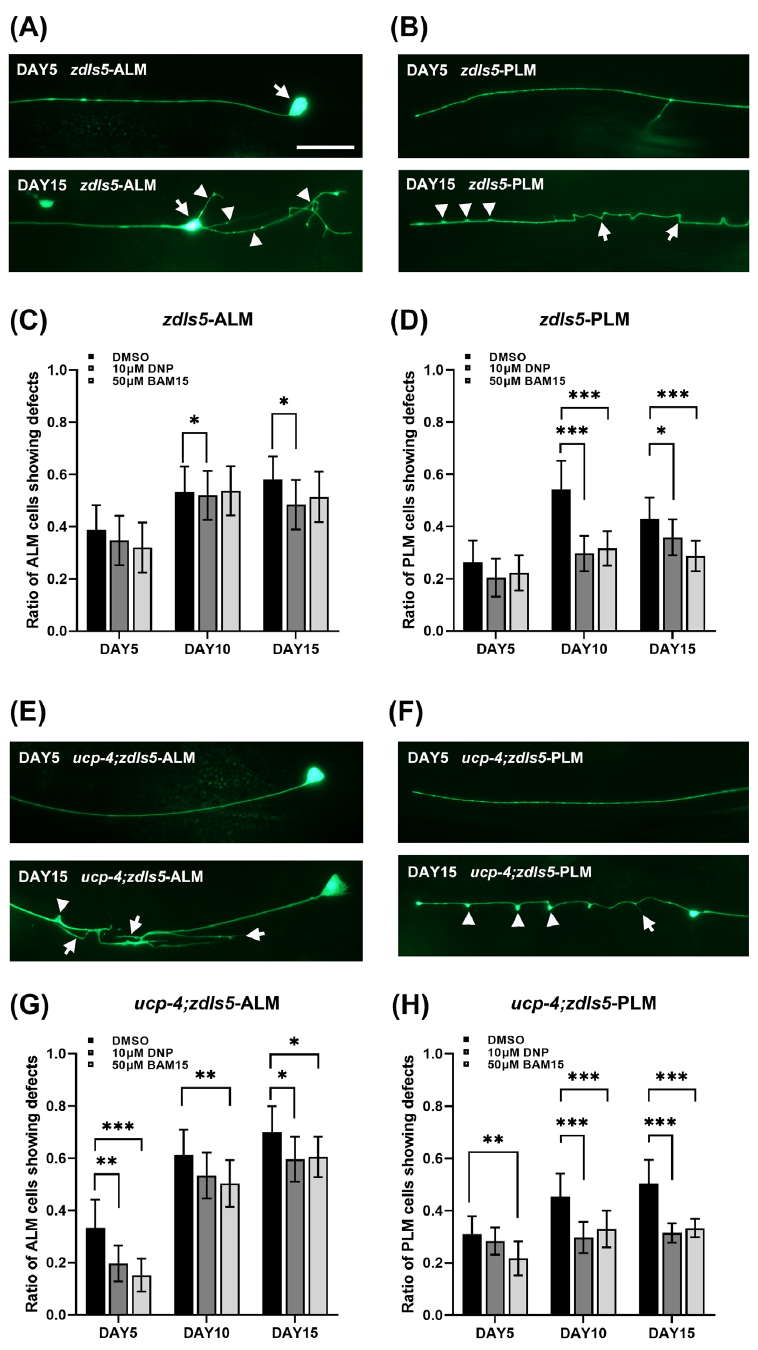
Figure 1. BAM15 attenuates neuronal defects in aged C. elegans . ( A , B ) Representative images of mechanosensory neurons in zdIs5 [ Pmec-4::GFP ] animals on Day 1 and Day 15; ALM and PLM, re- spectively. Arrows indicate soma and arrowheads indicate soma outgrowth and branching in ALM ( A ). Arrows indicate blebs and arrowheads indicate wavy processing in PLM ( B ). Scale bar = 50 µm. ( C , D ) ALM and PLM neuronal defects are presented as a ratio of the total ALM- and PLM-scored neurons in animals treated with 10 µM DNP and 50 µM BAM15 on Days 5, 10, and 15. ( E , F ) Repre- sentative images of mechanosensory neurons in ucp-4 ; zdIs5 animals on Days 1 and 15; ALM and PLM, respectively. Arrows indicate neuronal sprouting and arrowhead indicates a bleb in ALM ( E ).